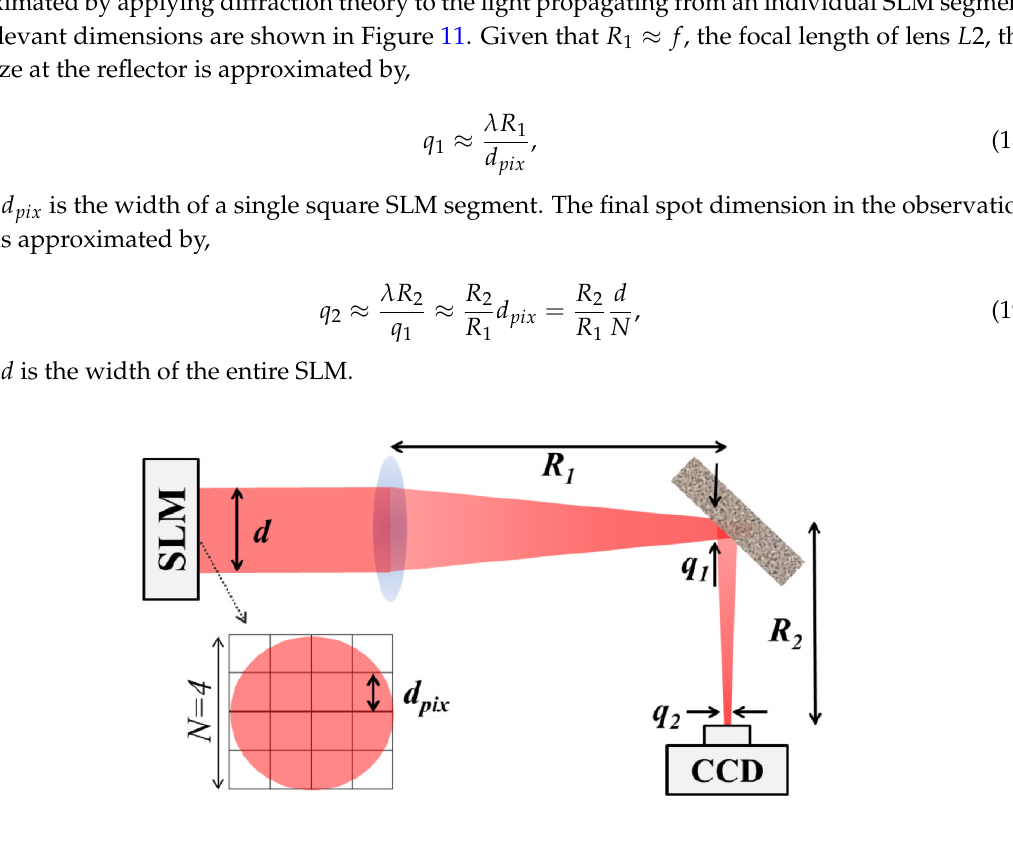
Figure 11. Experimental distance definitions for spot size